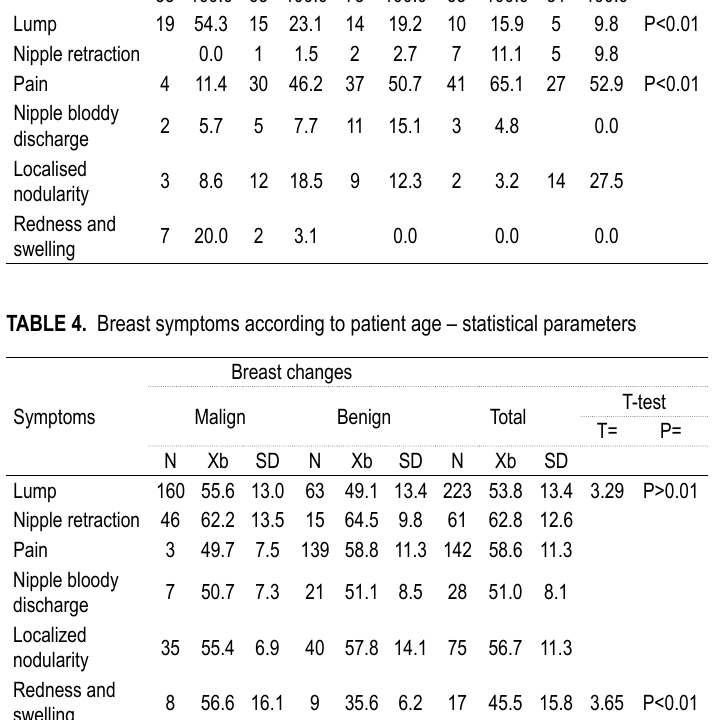
SD- Standard deviation, Xb- average age, t- student t test, P-